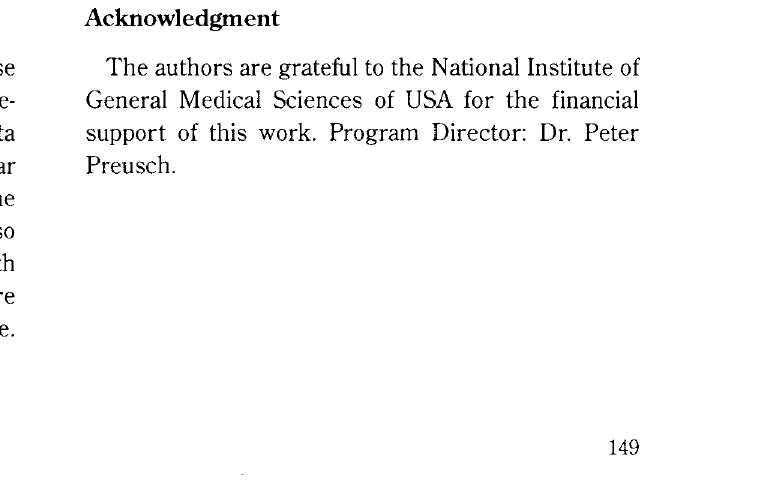
For intermediate temperatures, large values of stan dard deviation occur only over a narrow range of velocity; i.e. crystals appear to grow within